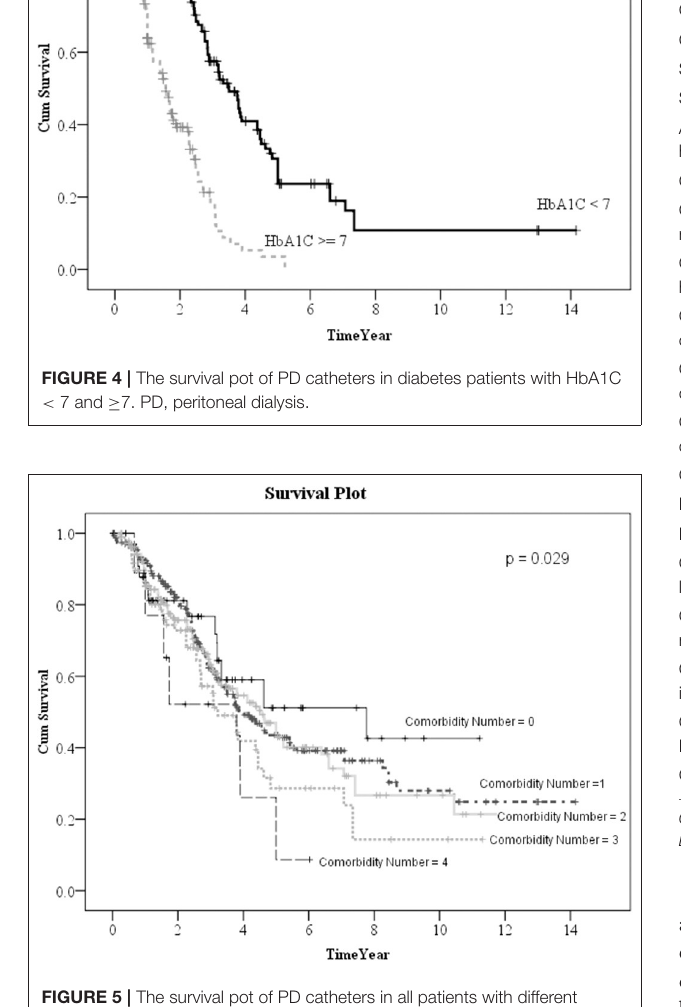
FIGURE 5 | The survival pot of PD catheters in all patients with different comorbidity number. PD, peritoneal dialysis.